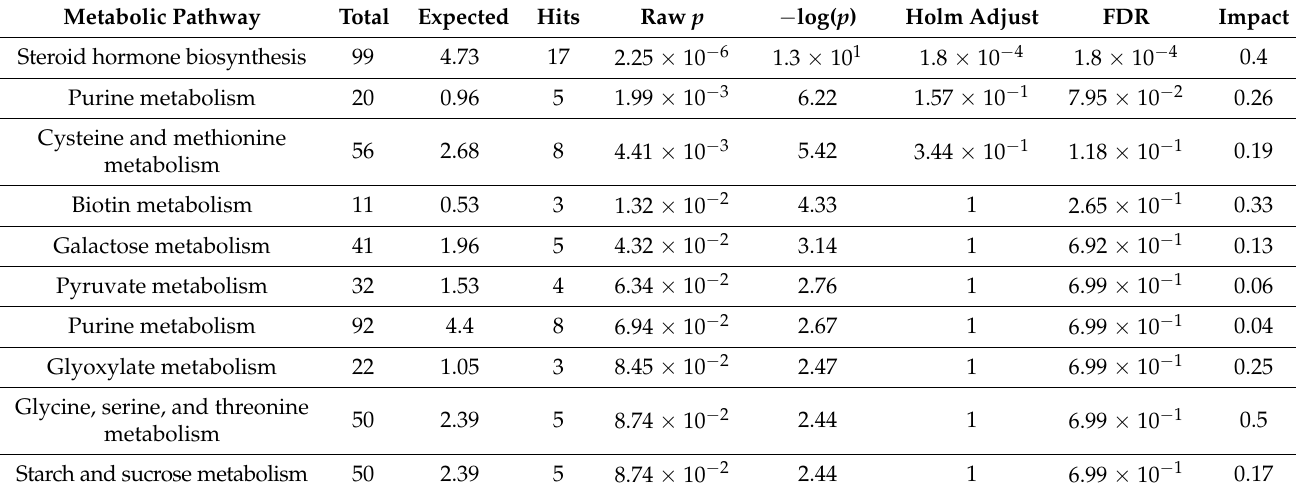
Table 2. The derivative pathway of digestate under aerobic